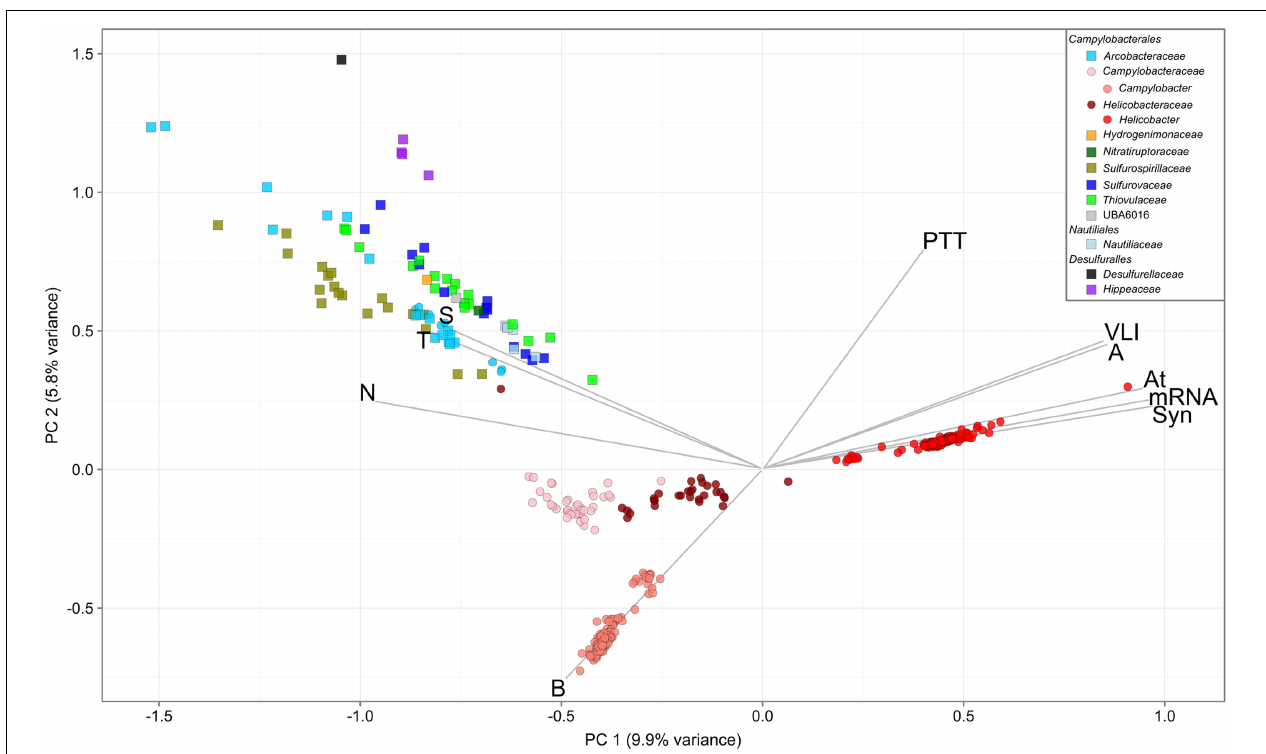
FIGURE 4 | Principal component analysis of Epsilonbacteraeota gene annotations. Analysis was performed using the KEGG Orthology (KO) annotation table. Circles denote host-associated individuals, and squares those from other environments. Genomes are colored by family, with exceptions of the Campylobacteraceae and Helicobacteraceae , which are separated based on suffixing described in text. Vectors represent pathway level aggregations of indicator KOs fitted to the ordination using the enfit function in vegan. Only vectors with R > 0.75 are displayed for clarity. Pathways are as follows: A, arginine biosynthesis; At, atrazine degradation; B, biotin metabolism; N, nitrogen metabolism; PTT, phenylalanine, tyrosine, and tryptophan biosynthesis; S, sulfur metabolism; Syn, synthesis and degradation of ketone bodies; T, two-component system; VLI, valine, leucine, and isoleucine